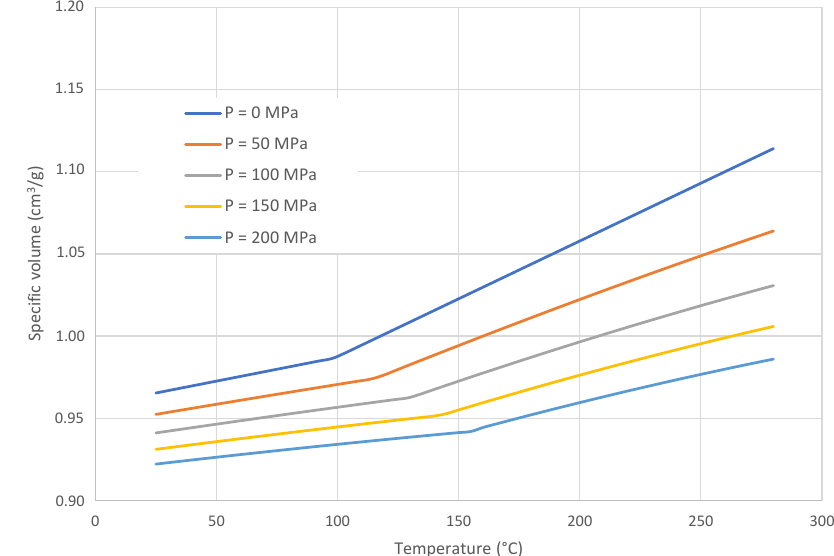
Figure 2. Variation of the polymer specific volume with temperature and pressure fields for the GPPS Styron